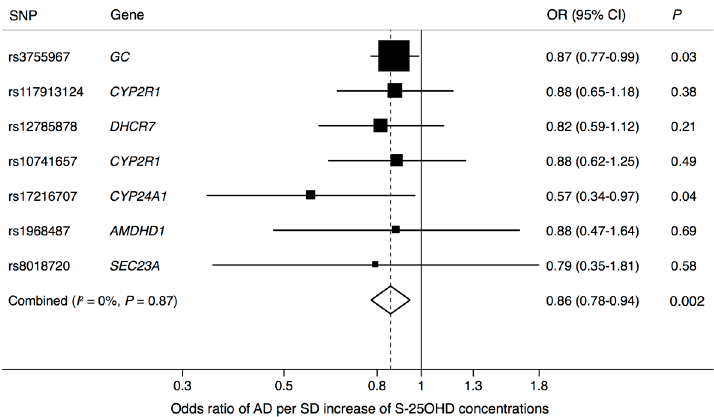
Figure 2. Association between a genetically predicted one standard deviation increase of S-25OHD concentration and Alzheimer’s disease. rs1968487 was used as proxy SNP for rs10745742 ( r 2 between these two SNPs =